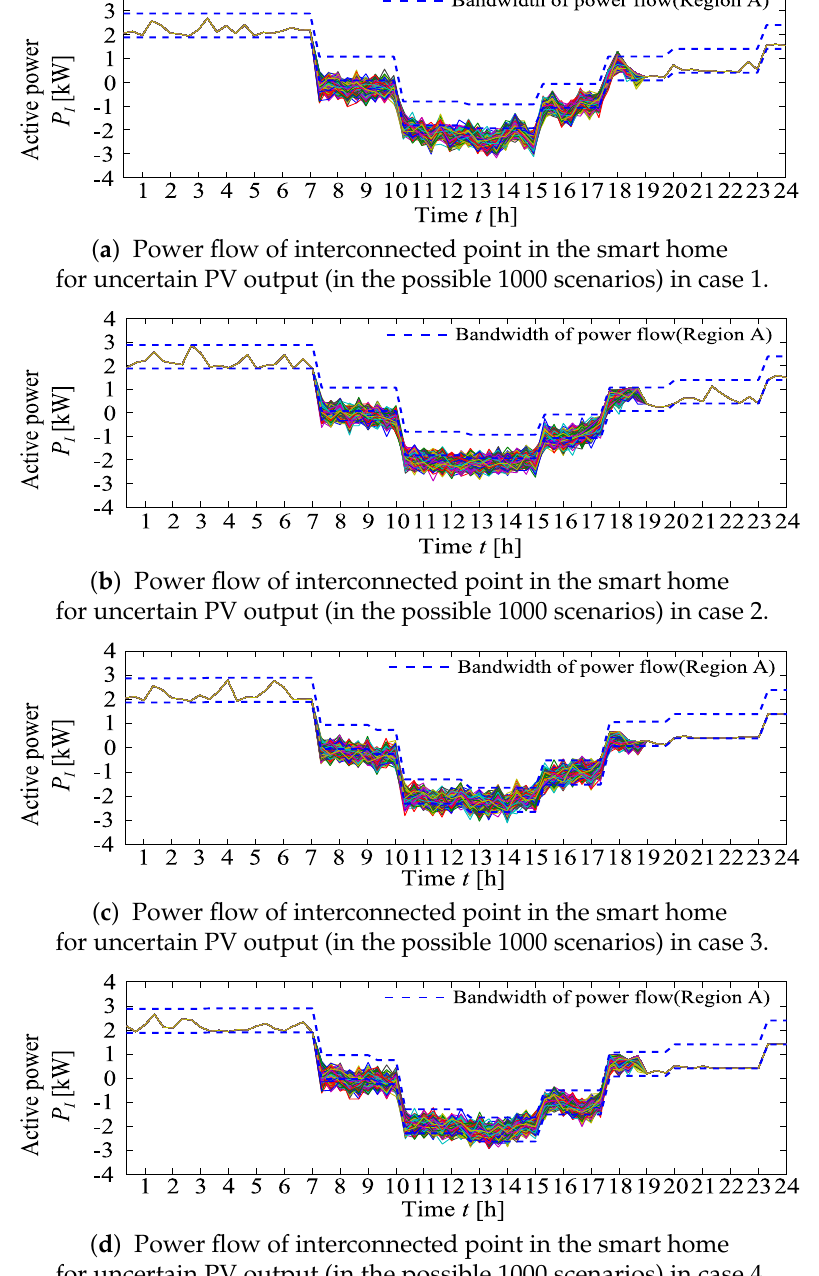
Figure 12. Statistical analysis result in regards to power flow in the smart home in each